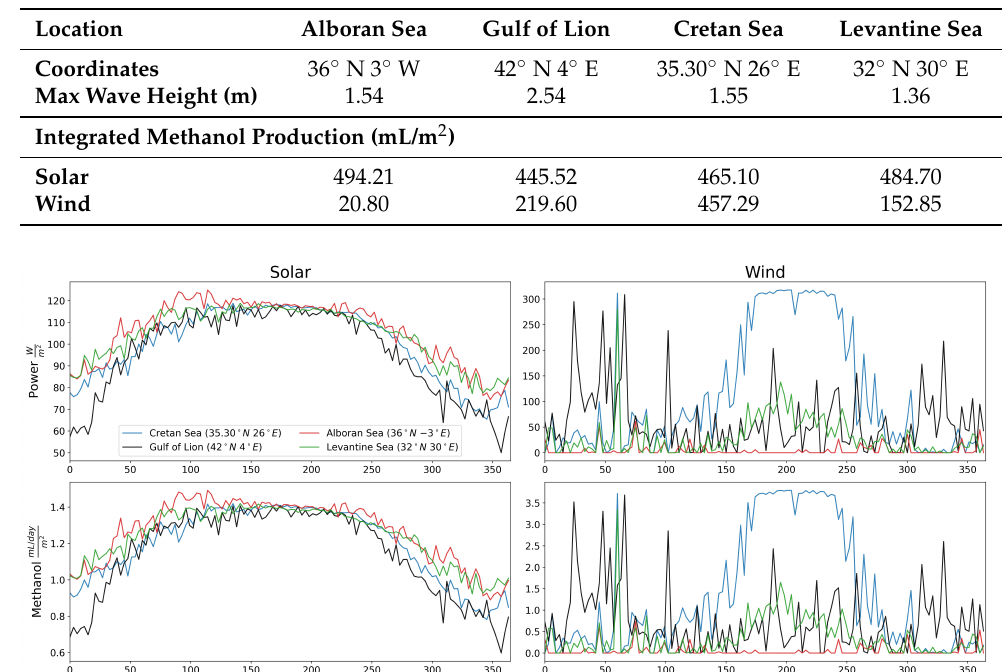
Table 2. Point locations examined in more detail due to their favorable solar and wind power generation.